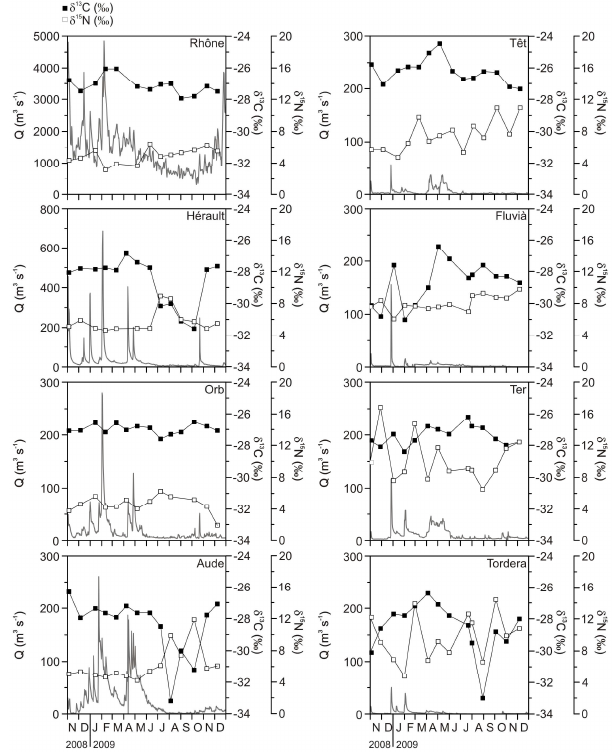
846 Figure 4. Temporal variability of the stable isotopes ( d 13 C and d 15 N) with the corresponding 847 Fig. 4. Temporal variability of the stable isotopes ( δ 13 C and δ 15 N) average daily water discharges (Q) of the eight studied rivers from November 2008 to 848 with the corresponding average daily water discharges ( Q ) of the eight studied rivers from November 2008 to December